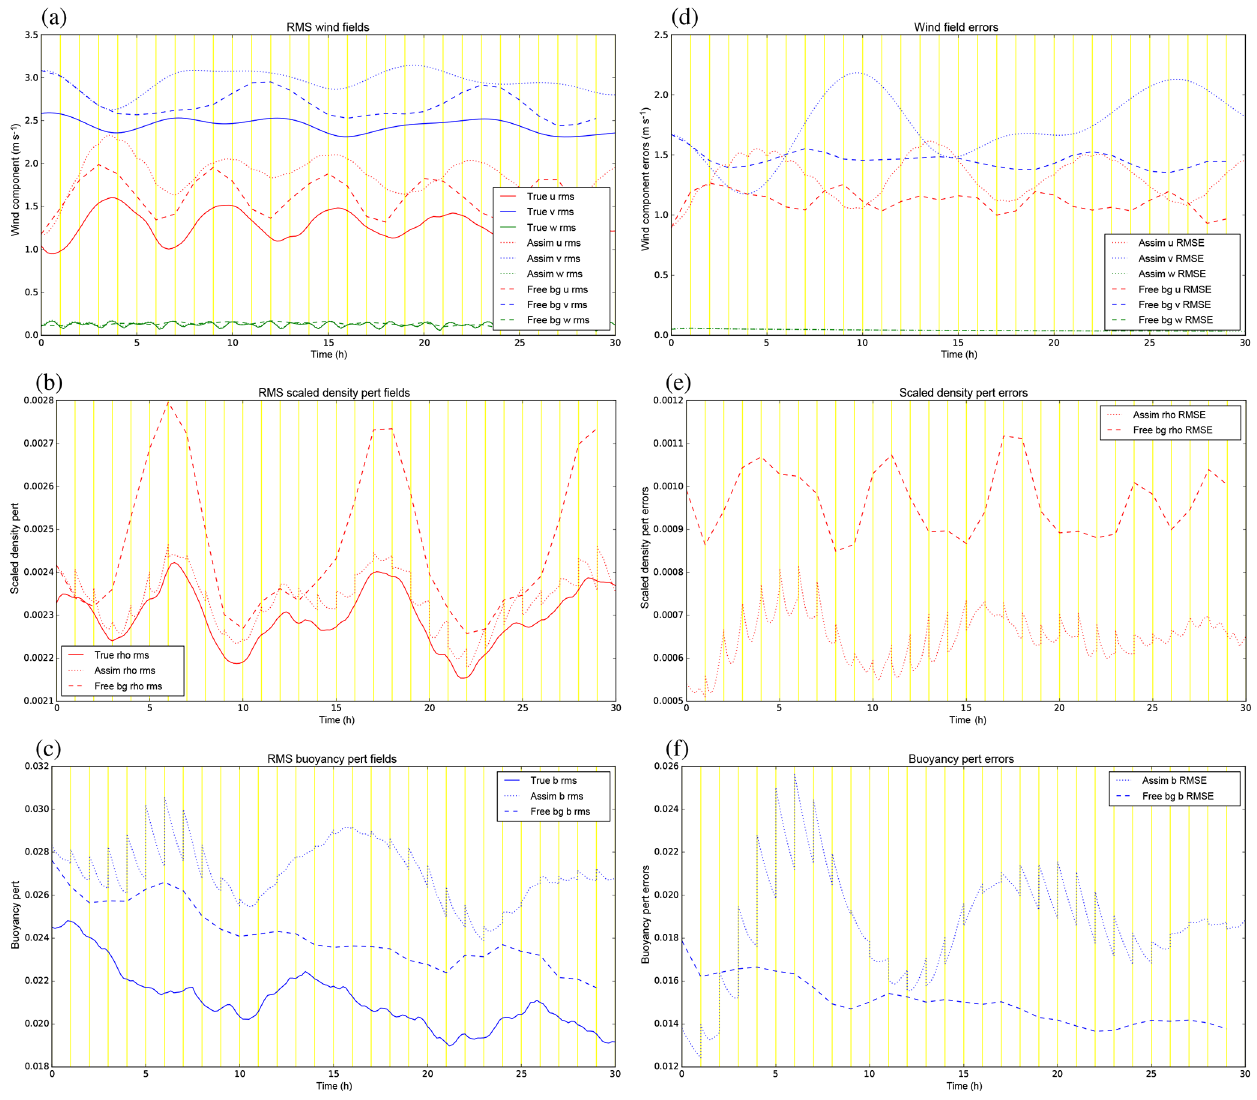
Figure 12. As Fig. 11 but for experiment GB −